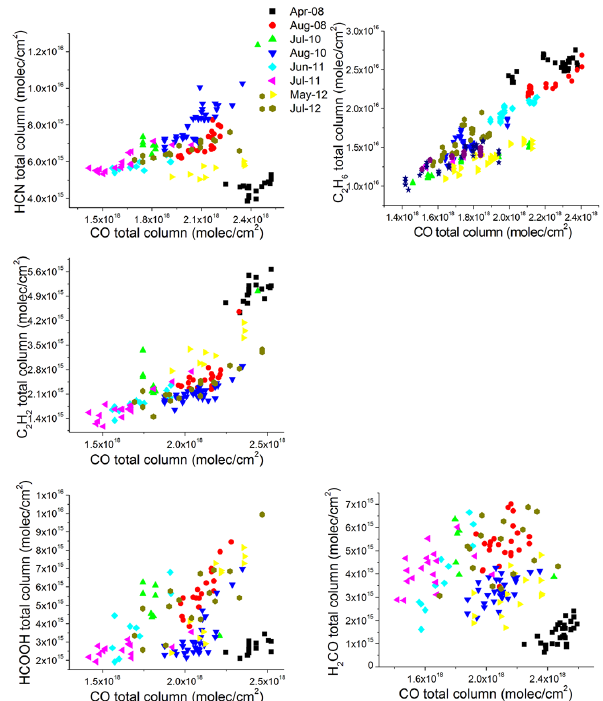
Figure 7. Scatterplots of the total columns of the target species (HCN, C 2 H 6 , C 2 H 2 , CH 3 OH, HCOOH, and H 2 CO) relative to CO for the ten fire events detected at Eureka (2008–2012).